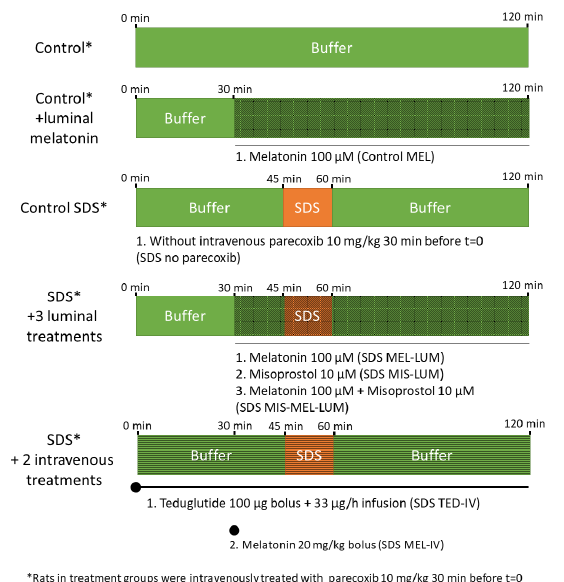
Figure 5. The luminal compositions, conditions, and treatments of the nine di ff erent experiments. The jejunum of rats ( n = 6) was single-pass perfused for 120 min with a pH 6.5 saline bu ff er solution (Control) with or without adding the mucosal irritant SDS at 5 mg / mL between 45 and 60 min. At 30 min before the start of the SDS experiments, all groups except one (Control SDS without parecoxib) were intravenously (IV) pretreated with 10 mg / kg parecoxib, a selective cyclooxygenase-2 inhibitor. The three experimental drugs—melatonin, misoprostol, and teduglutide—were luminally and / or intravenously administered, individually or in combination, to the rats in order to evaluate their e ff ects on the SDS-induced mucosal damage. A mesh illustrates that drug is added to the luminal perfusate (bu ff er and / or SDS), and stripes illustrates that drug is added intravenously while no change is made to the luminal perfusate. Table 2. Conditions and treatments of the nine di ff erent experiments. The jejunum of rats ( n = 6) was single-pass perfused for 120 min with a pH 6.5 saline bu ff er solution (Control) with or without adding the mucosal irritant SDS at 5 mg / mL between 45 and 60 min. Before the start of the jejunal perfusions, all groups except one were intravenously (IV) pretreated with 10 mg / kg parecoxib, a selective cyclooxygenase-2 inhibitor. The three experimental drugs—melatonin (MEL), misoprostol (MIS), and teduglutide (TED)—were luminally (LUM) and / or intravenously (IV) administered, individually or in combination, to the rats in order to evaluate their e ff ects on SDS-induced mucosal damage. Experimental